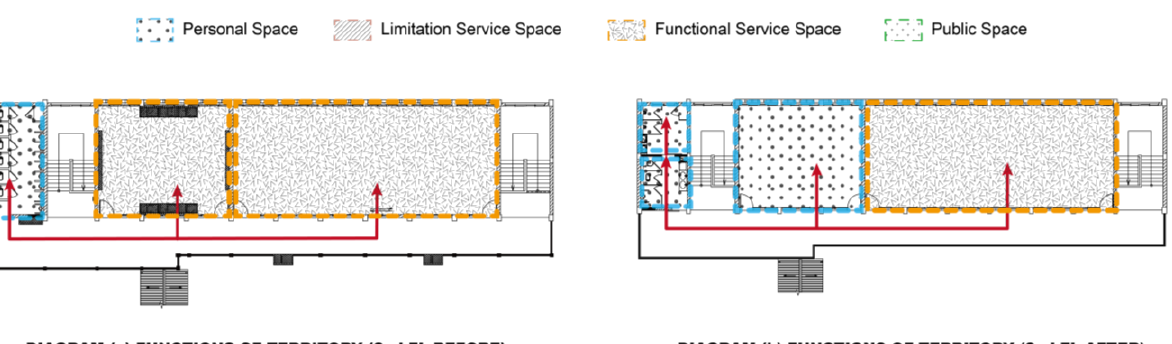
Figure 13. Pingtung Education Innovation Unit Territory Order Diagram: First Floor Plans. ( a ) First Floor Plan Before Redesign. ( b ) First Floor Plan After Redesign.